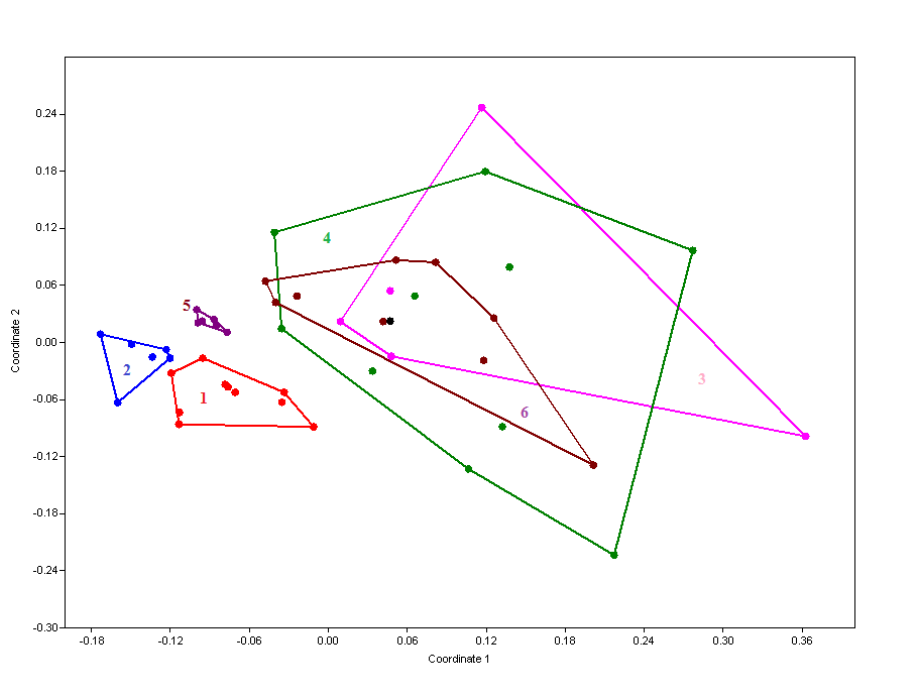
Fig. 3. PCoA plot of L. peltata populations studied based on morphological characters (Populations 1-6 are according to Table